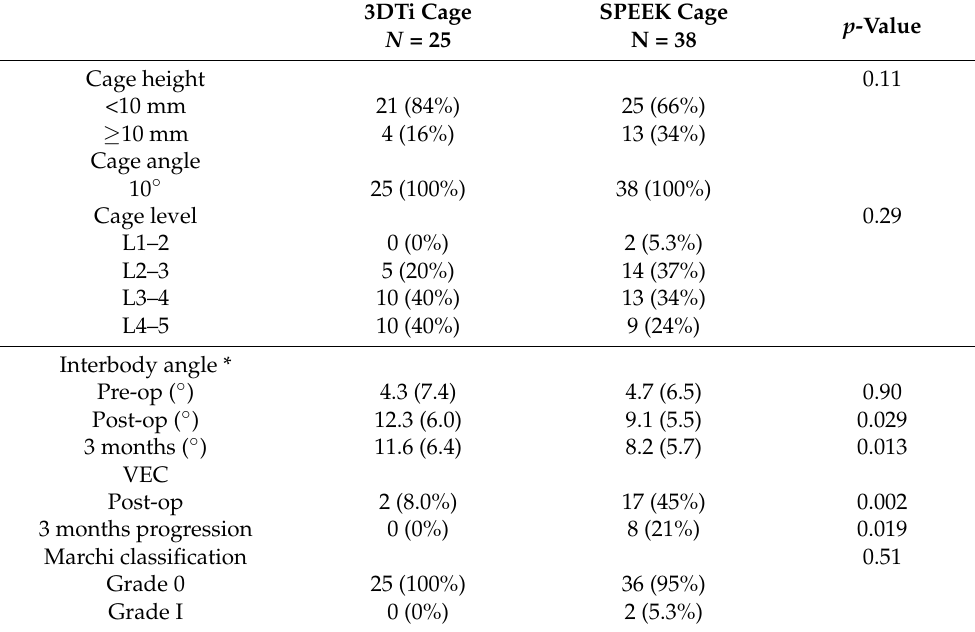
Table 3. Summary of each interbody compared by